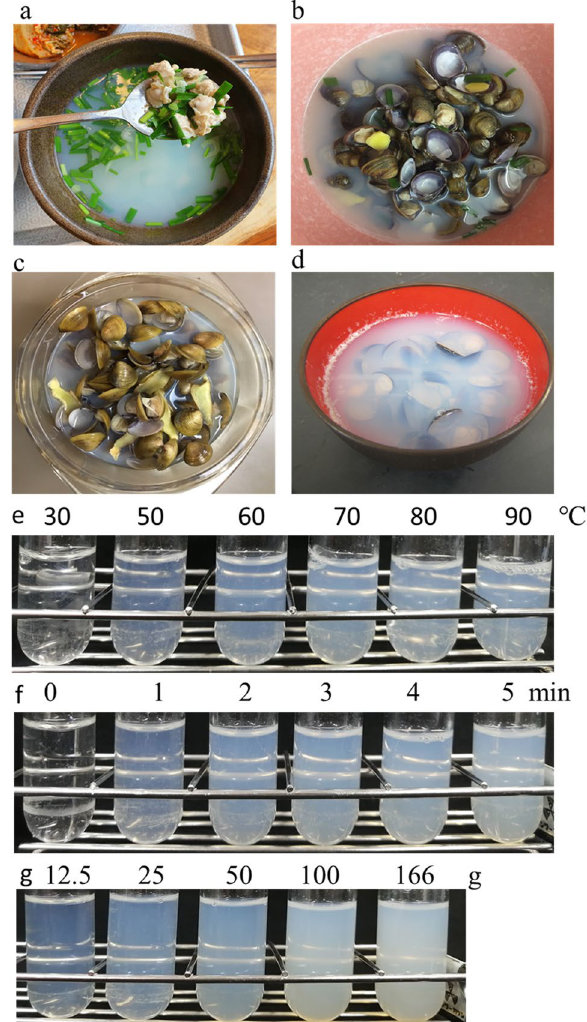
Figure 1. Soup with basket clam. ( a ) South Korean soup (jaechup-guk ). ( b ) Chinese soup ( xi ǎ n bèi jiàng tang ). ( c ) Taiwanese soup ( xi ǎ n tang ). ( d ) Japanese soup ( shijimi-jiru ). ( e ) One hundred grams of sample placed in 200 mL of water was heated at 30, 50, 60, 70, 80, and 90 °C for 30 min. ( f ) One hundred grams of sample suspended in water was boiled for 0, 1, 2, 3, 4, and 5 min. ( g ) 12.5, 25, 50, 100, and 166 g of sample suspended in 100 mL of water were boiled for 3